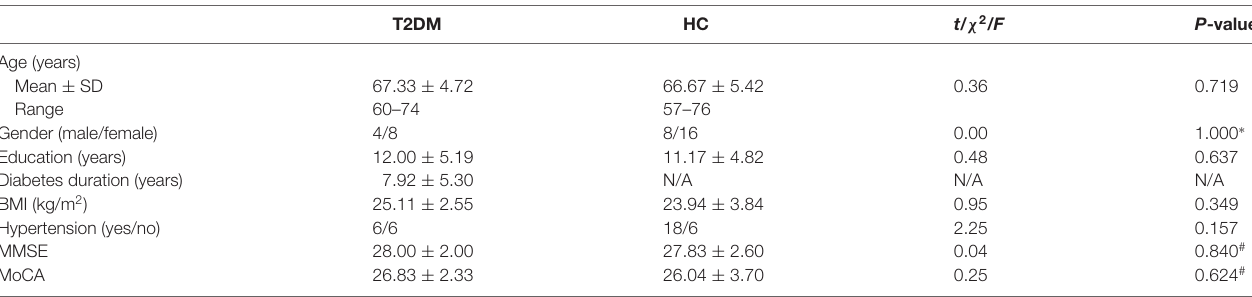
TABLE 1 | Demographic and clinical characteristics in type 2 diabetes mellitus (T2DM) and healthy control (HC)